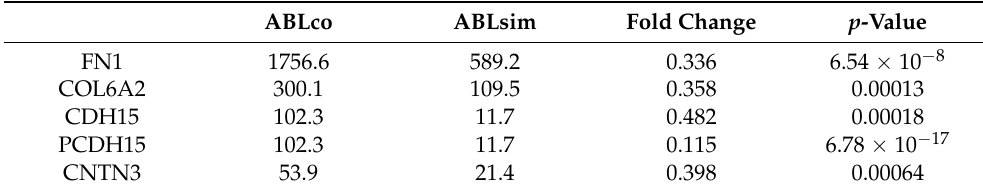
Table 2. List of significantly downregulated genes (fold change < 0.5, n = 3) in ABLsim compared to ABLco cells.